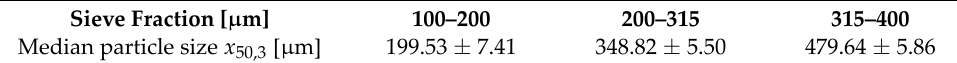
Table 1. Averaged median diameters of the investigated particle size fractions.